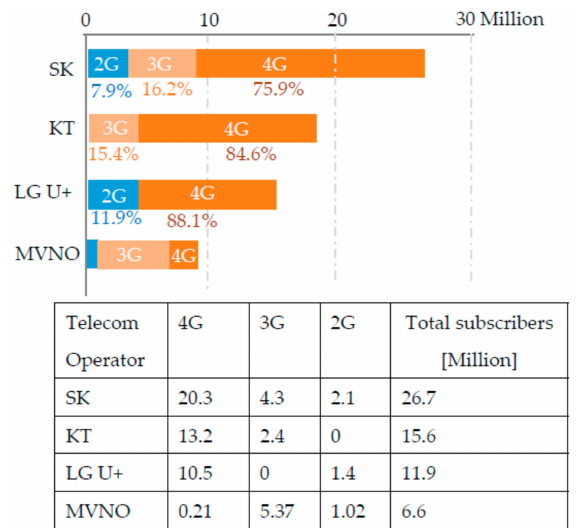
Figure 1. Mobile subscribers by operator in South Korea (Q3 2016) [2].